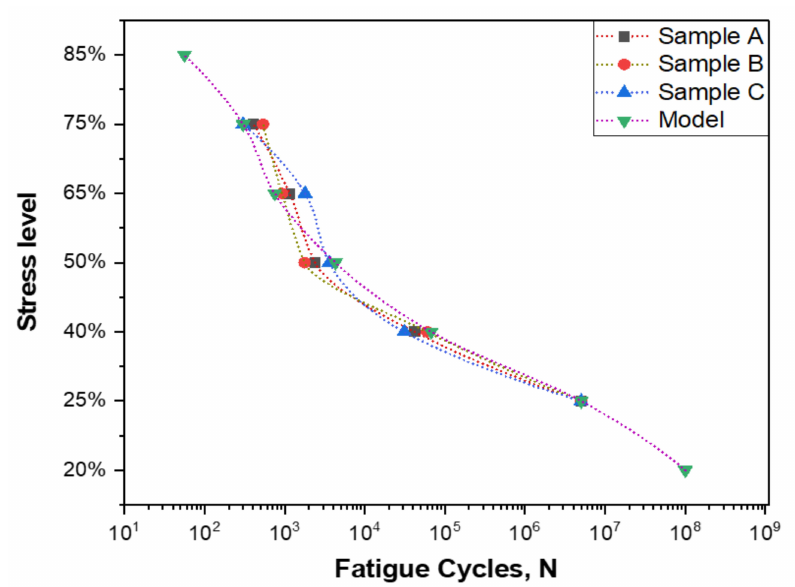
Figure 12. Influence of stress level on fatigue life of glass fibre-reinforced polyester composites; experimentally and